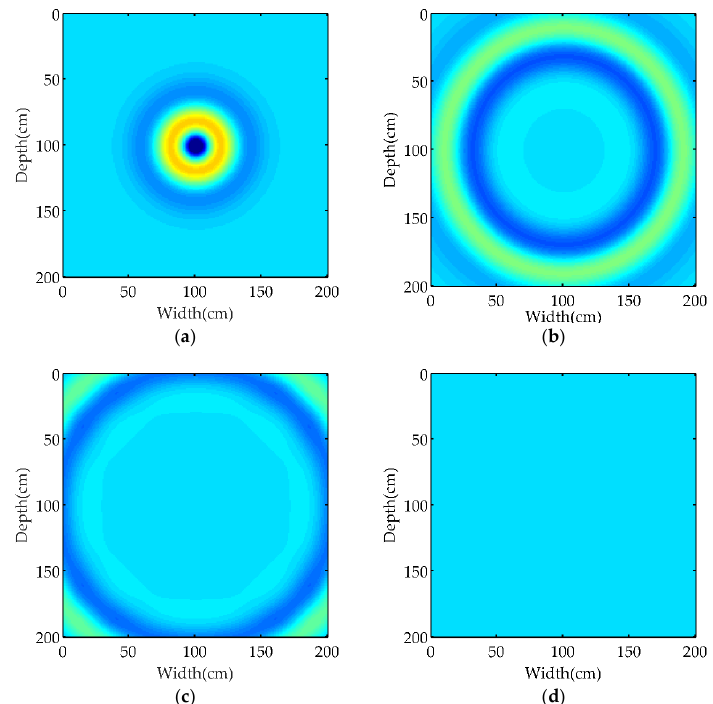
Figure 4. Snapshots of the wave field of E z at different times: ( a ) At 2 ns; ( b ) At 3 ns; ( c ) At 4 ns; ( d ) At 5 ns.